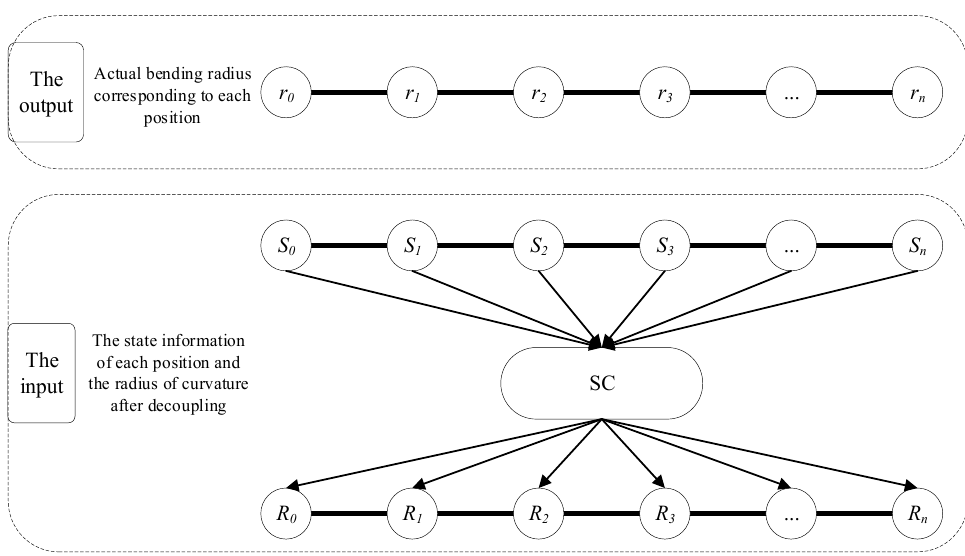
Figure 7. Variable-Curvature Prediction Input–Output Structure.